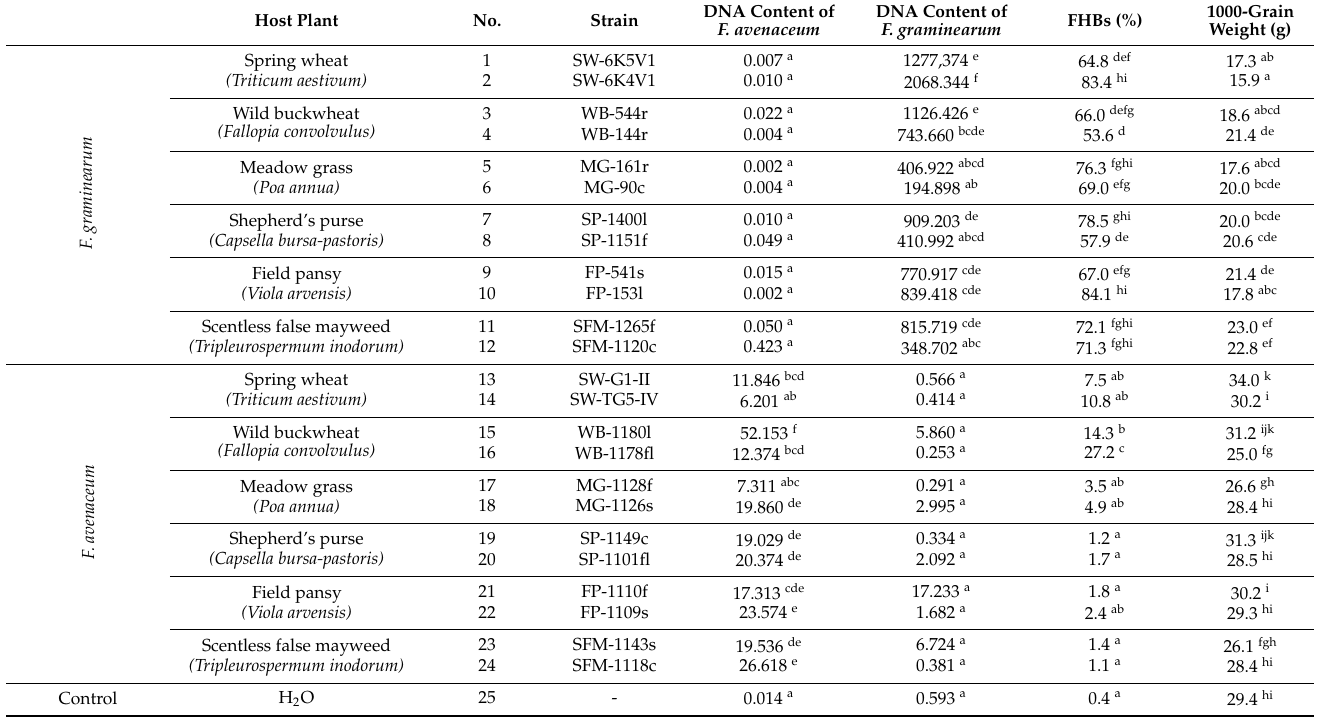
Table 4. The relative concentration of DNA of the fungus F. avenaceum and F. graminearum (pg Fusarium spp. DNA/ µ g plant DNA) in spring wheat grains inoculated with F. avenaceum and F. graminearum strains, fusarium head blight severity (FHBs), and 1000 grains weight of spring wheat. Values with letters (a–i) indicate statistically significant differences ( p < 0.05) between study variants. No. Strain DNA Content of F. avenaceum DNA Content of F. graminearum FHBs (%) 1000-Grain Weight (g)